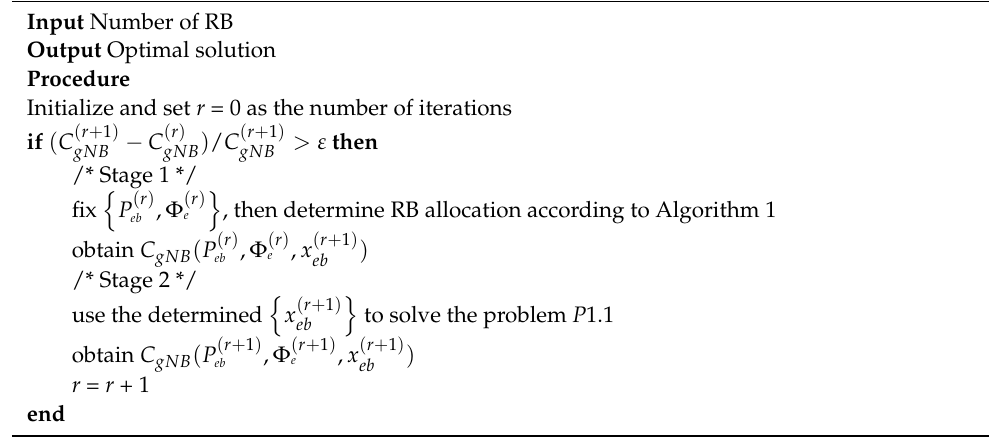
Algorithm 2. Alternating iteration-based eMBB allocation